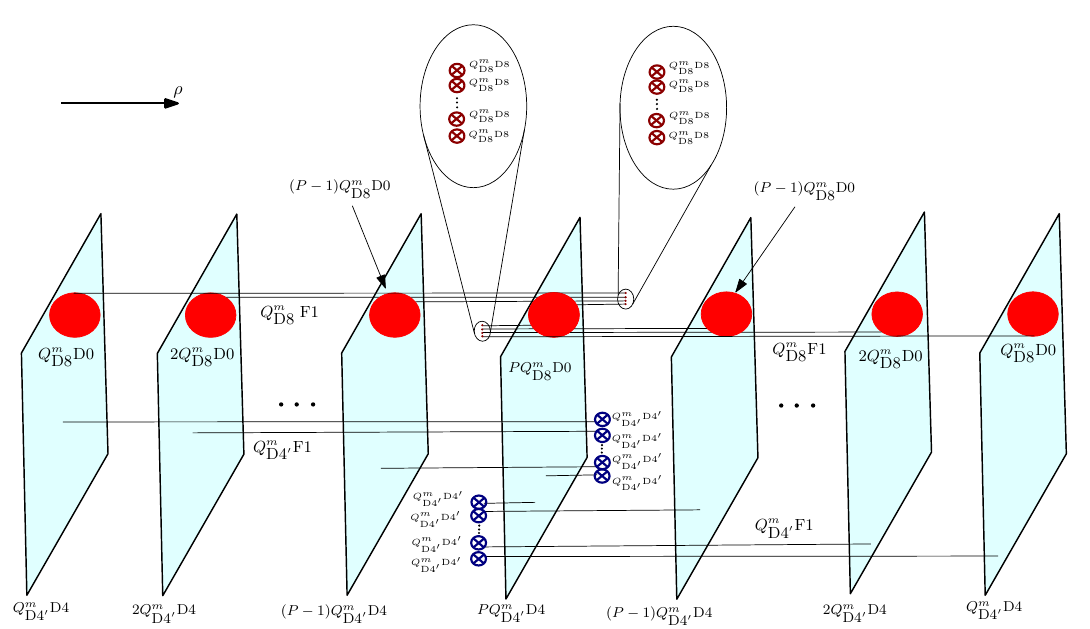
Figure 6 . Symmetric brane set-up after a T+S+T duality transformation and Hanany-Witten moves from the brane set-up depicted in figure